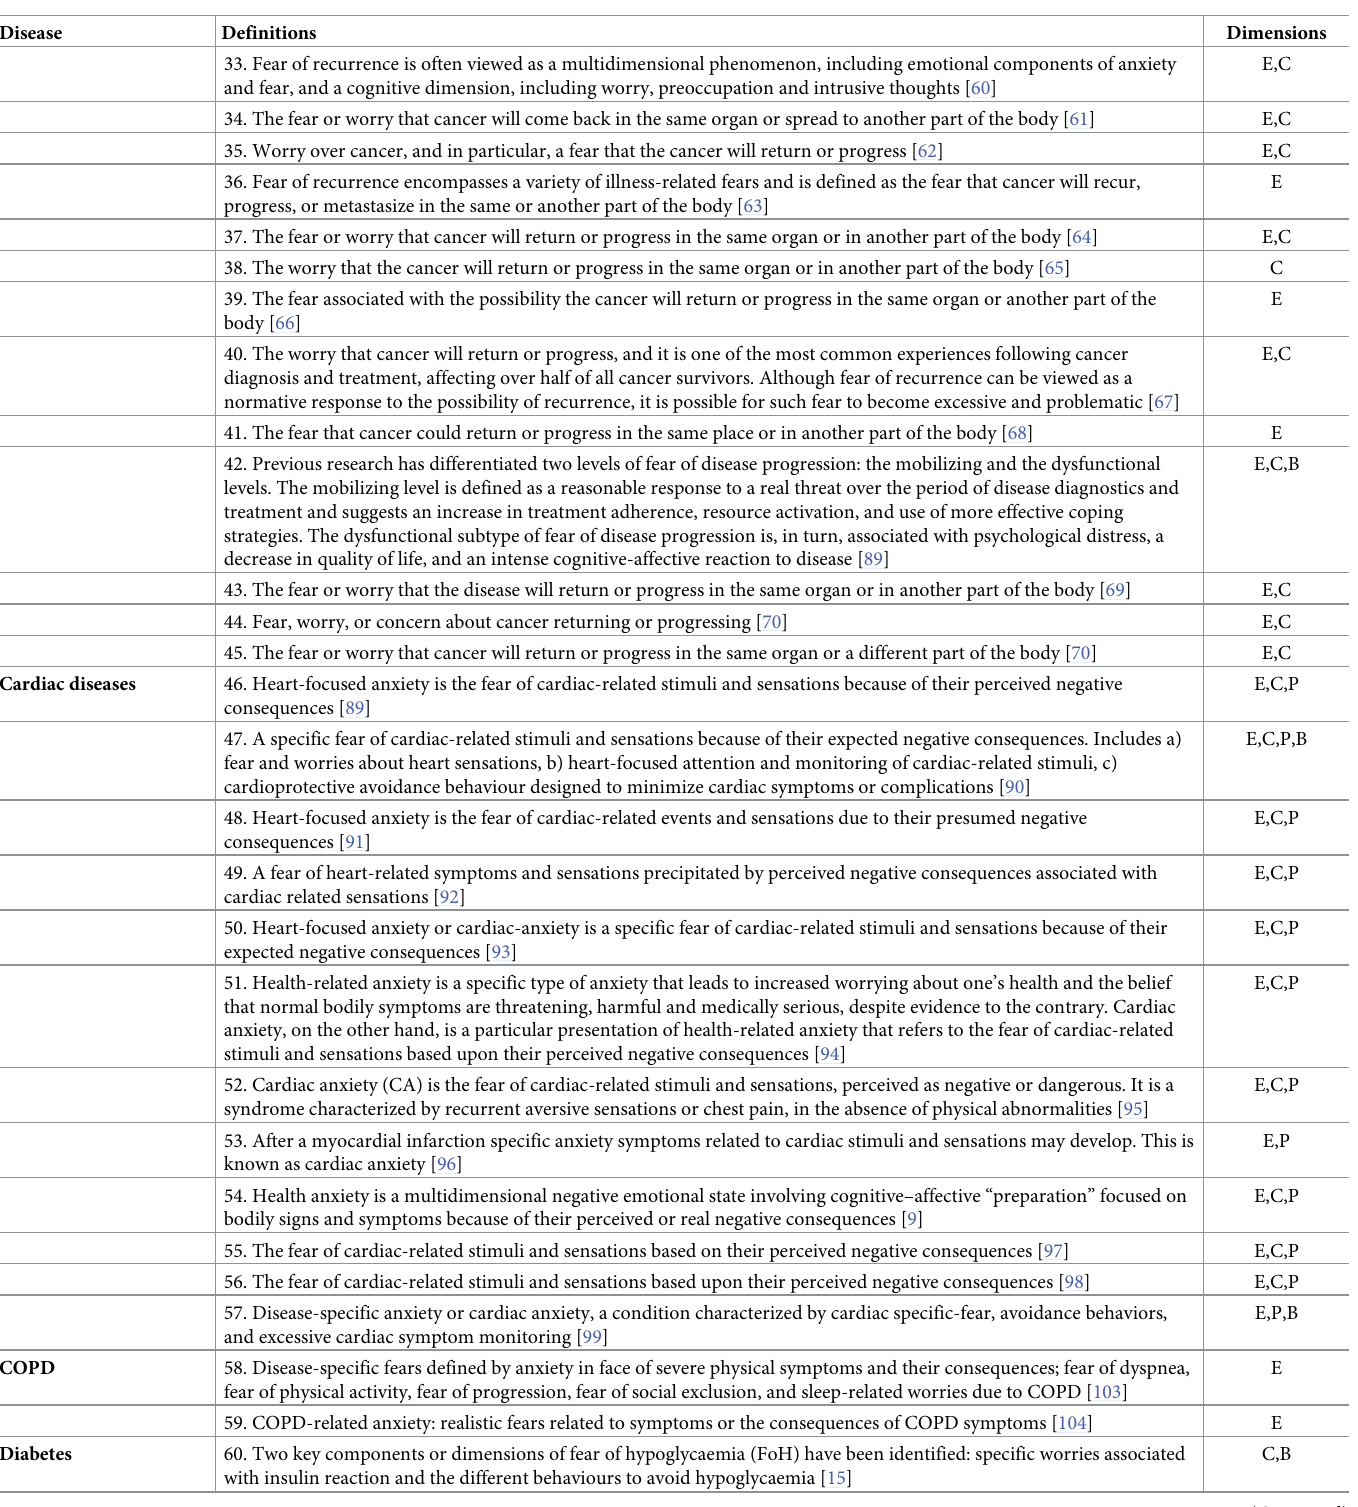
Disease Definitions